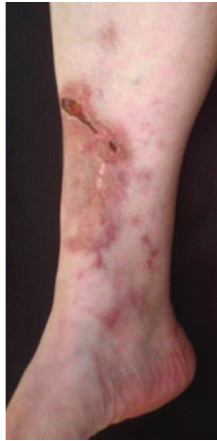
Figure 1: Vasculitic leg ulcer, in spite of the usage of high-dose prednisone (1mg/kg/day).